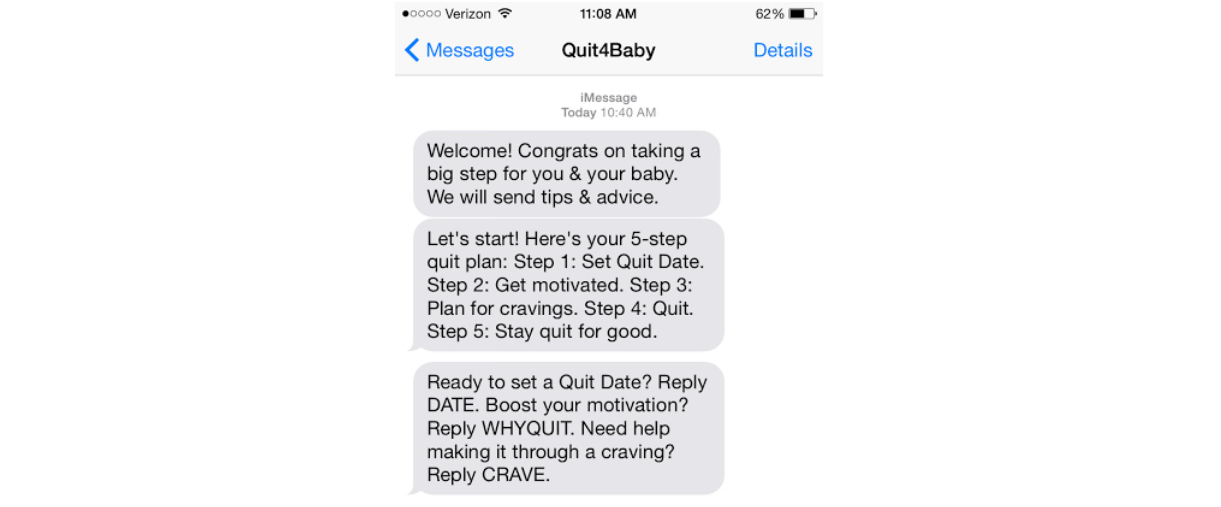
Figure 1. Quit4Baby